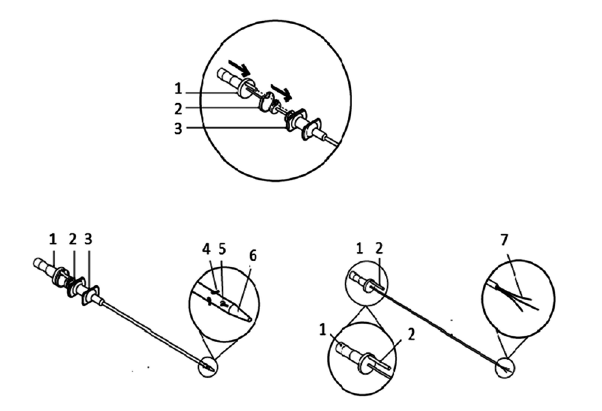
Fig. 1 – Schematic presentation. The instrument has a locking mechanism (1,2,3) and is composed of an external needle with blunt tip, with multiple 0.5 mm diameter holes (4,5). Internally it is fitted with a mandrill needle, which can be mobilized inside occluding or releasing the lateral holes. The procedure for producing micro lesions is done by exchanging the blunt mandrill for a brush-mandrill, provided with micro bristles that are structurally designed to fill the holes with small exteriorization of bristles (6). As an option to brush mandrill there is a second self-expandable feather shaped mandrill (7)